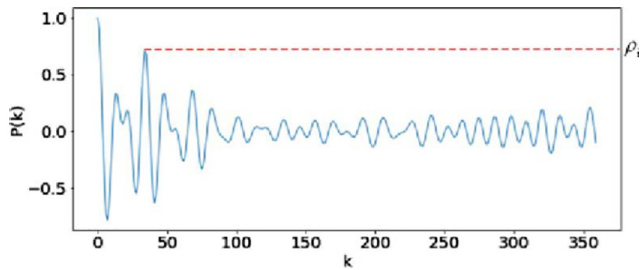
Fig 9. Autocorrelation coefficient P i ( k ) and maximum autocorrelation coefficient ρ i of component i .